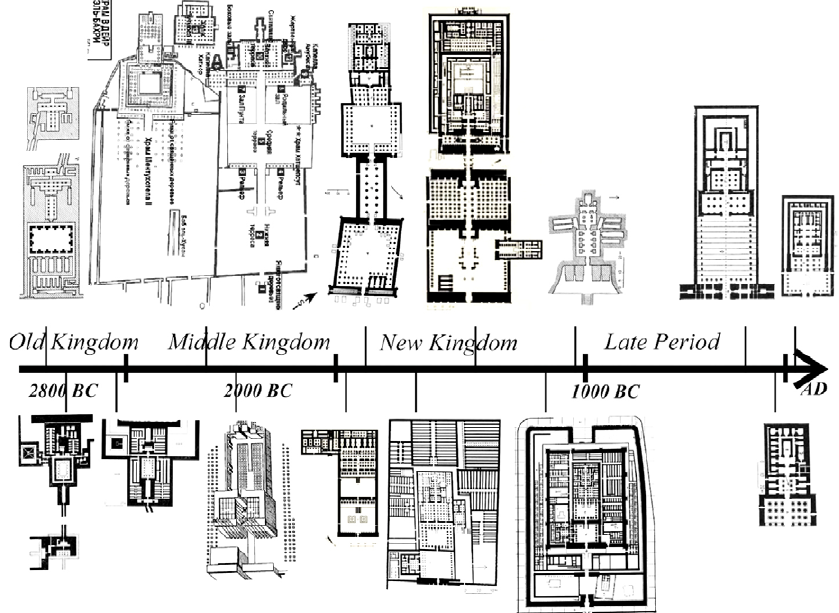
Figure 1. Scheme of the evolution of the canon for constructing of ancient Egyptian